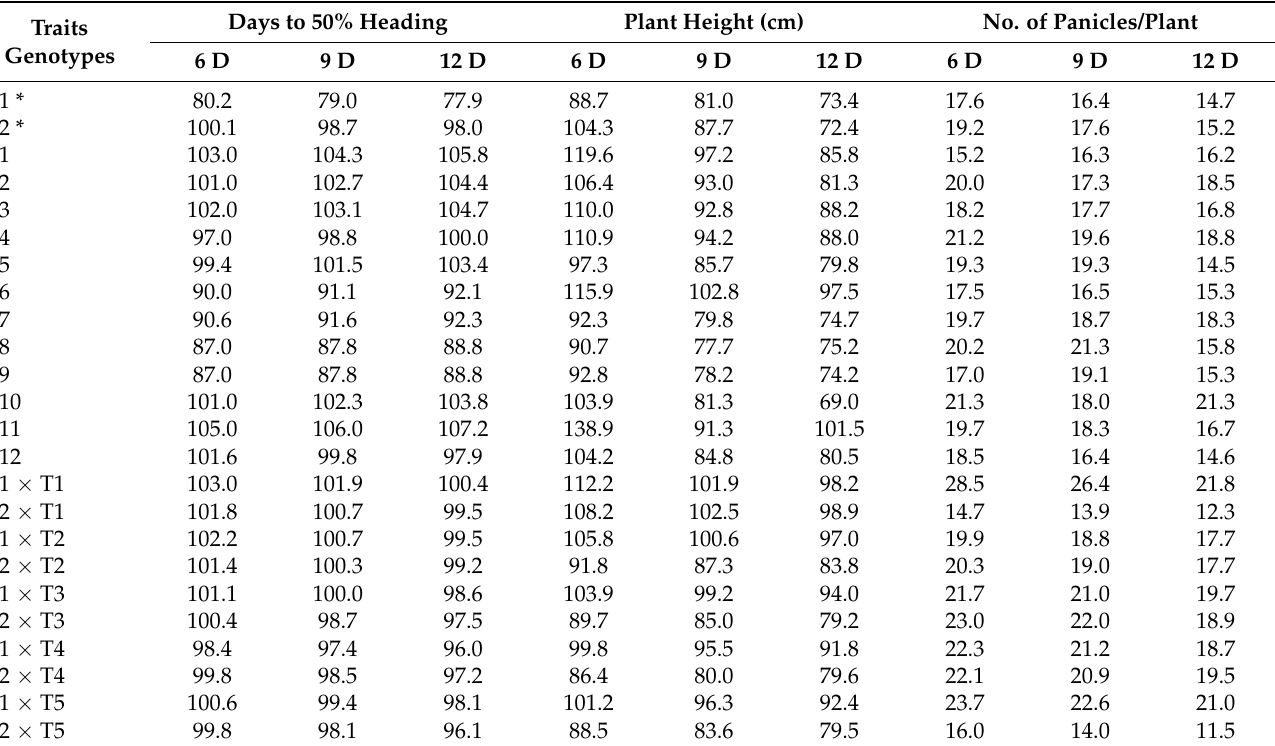
Table 2. Mean performance for days to heading, plant height, and the number of panicles/plant of the studied